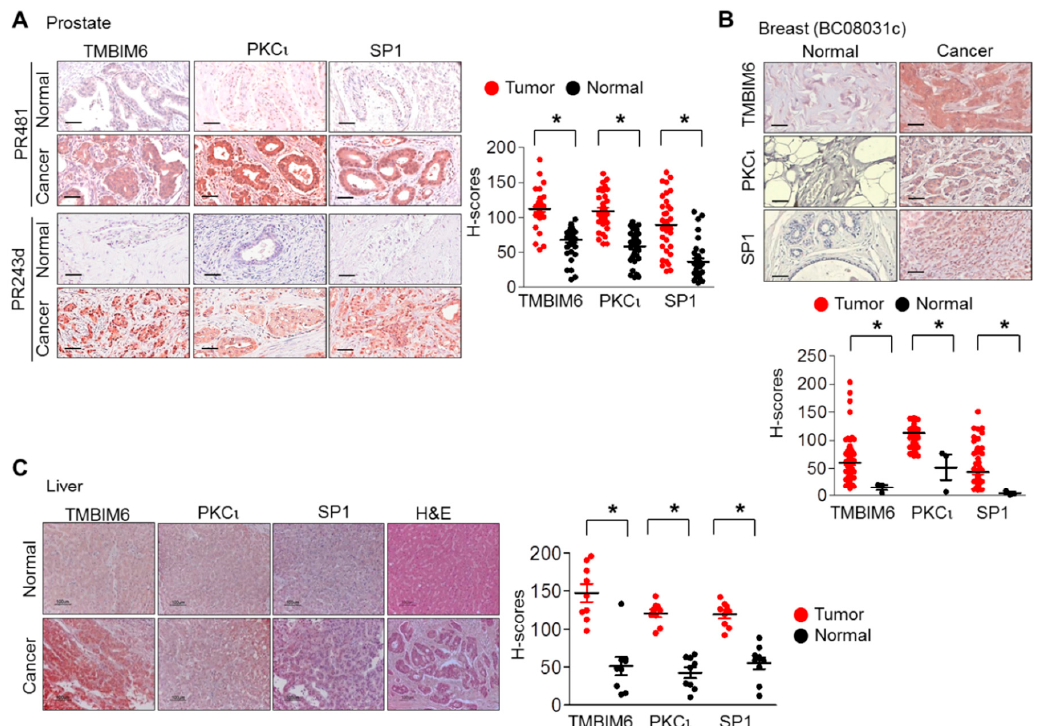
Figure7. TMBIM6,Sp1,andPKC ι expressionincreasedincancerpatientsamples. ( A – C )Immunohistochemical staining of prostate ( A ), breast ( B ) tissue microarray sections and liver samples ( C ). Lower and right panel were presents of quantification data. Scale bar represents 100 µ m. (brown: positive antibody staining, blue: hematoxylin for nucleus staining). ‘*’ indicate significant di ff erences of respective gene expression between normal and tumor